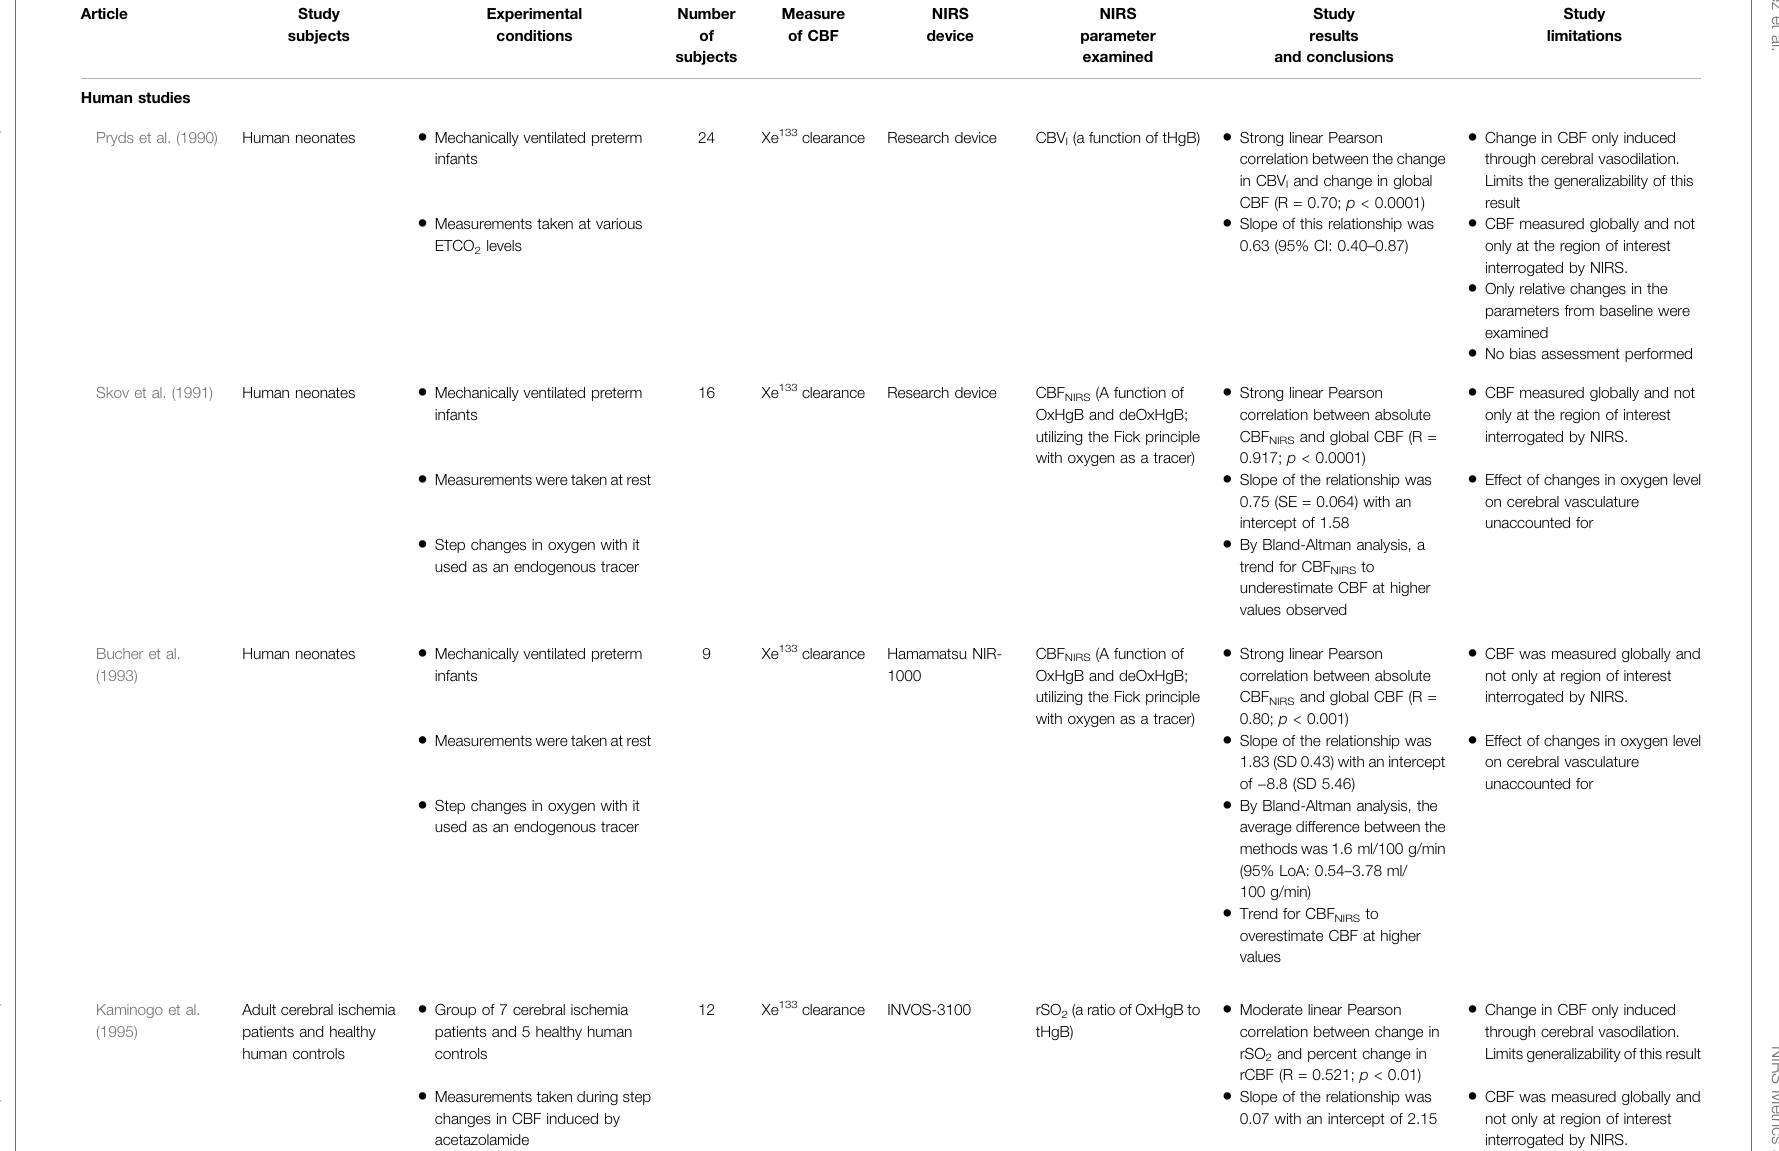
TABLE 1 | Summary of articles examining continuous wave near infrared spectroscopic (CW-NIRS) cerebrovascular